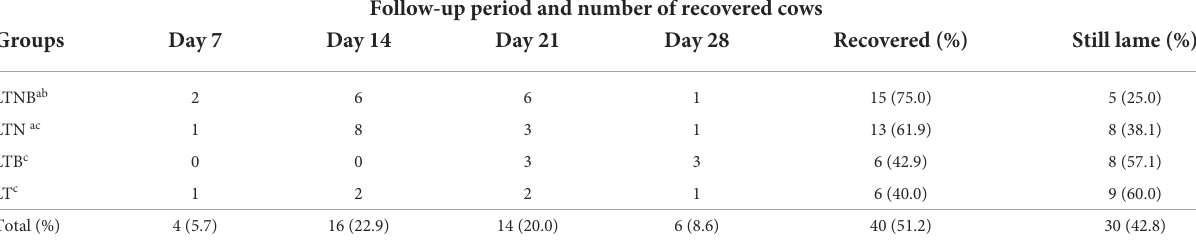
TABLE 5 Number of recovered cows at various follow-up periods in each treatment and the final recovery rate at 28 days after treatment. Follow-up period and number of recovered